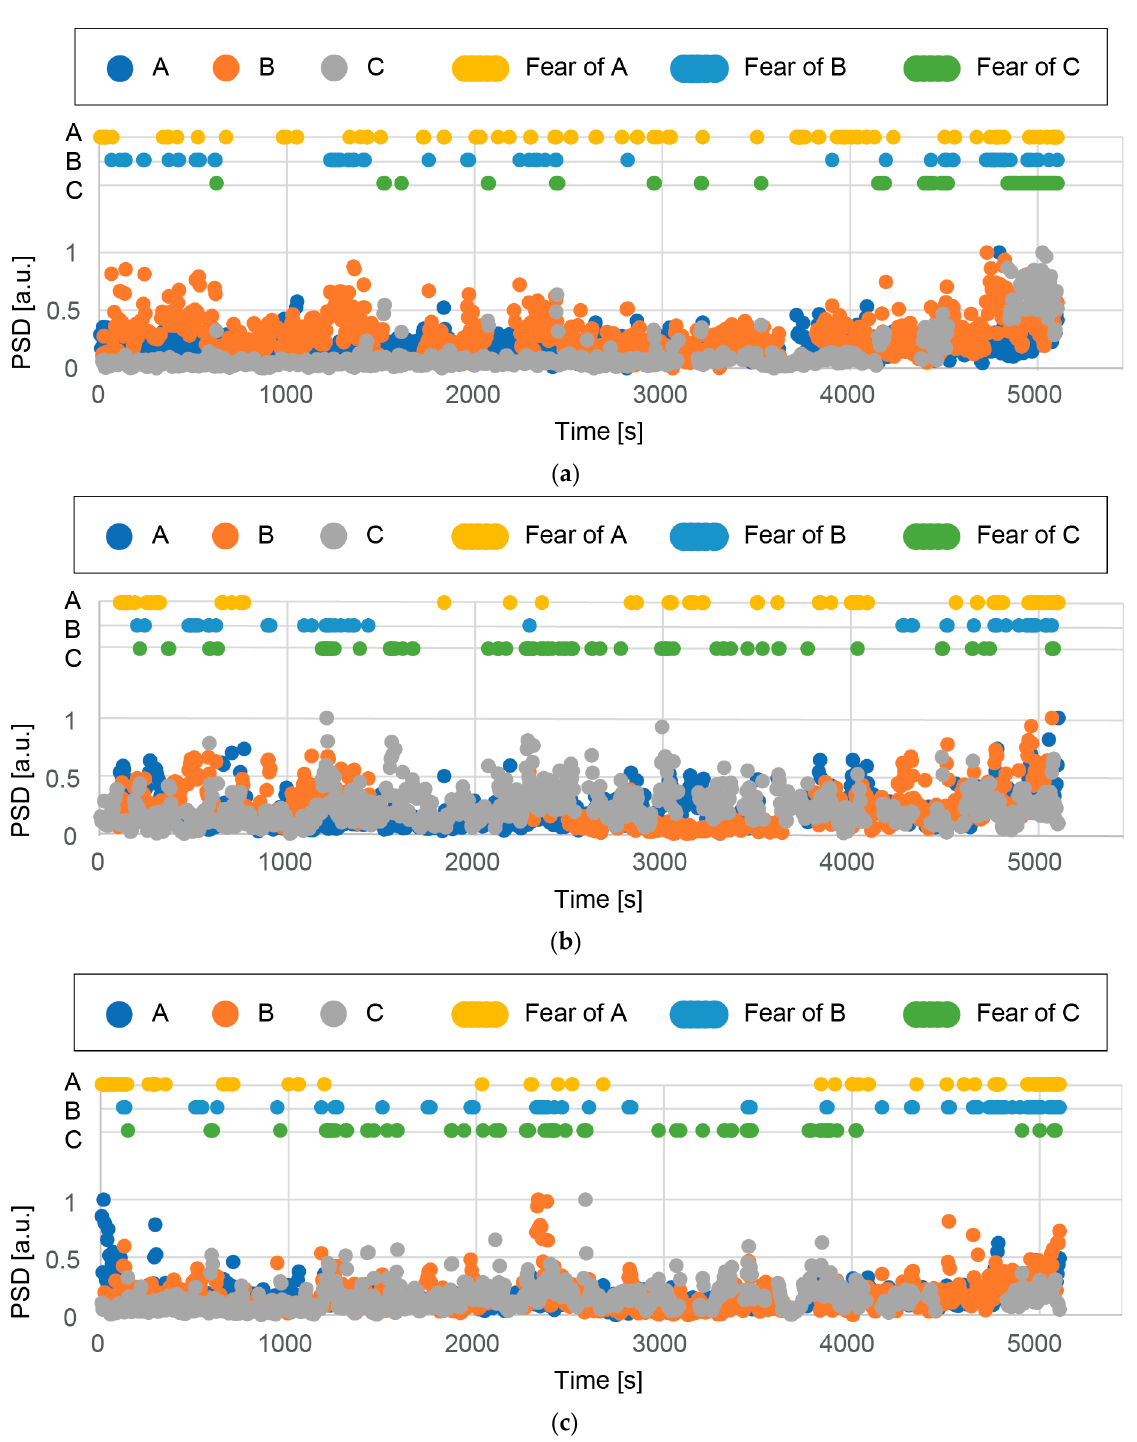
Figure 12. Normalized PSD for high- β / α for participants ( a ) A, ( b ) B, and ( c ) C. In the figures, the time when the PSD for high- β / α is in the top 10% is also shown with respect to the measurement sites. The analysis was conducted for periods of 5 s.